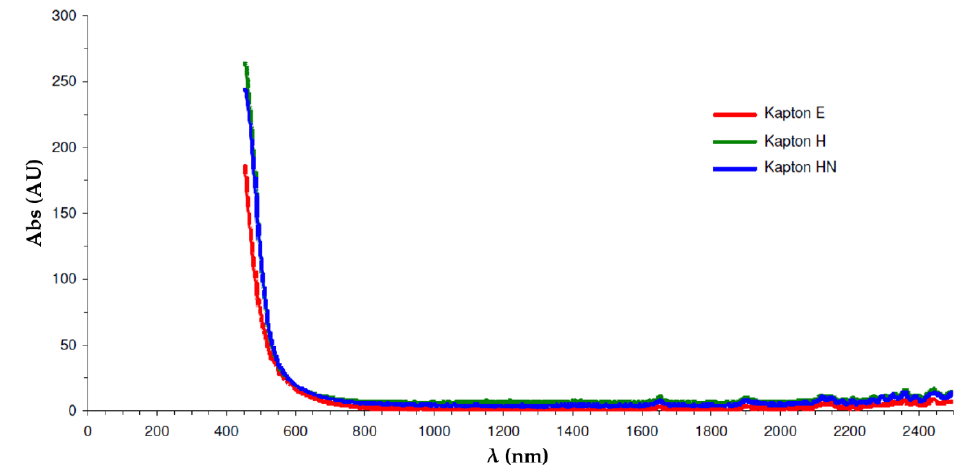
Figure 4. Optical absorbance of some common polyimide polymers.